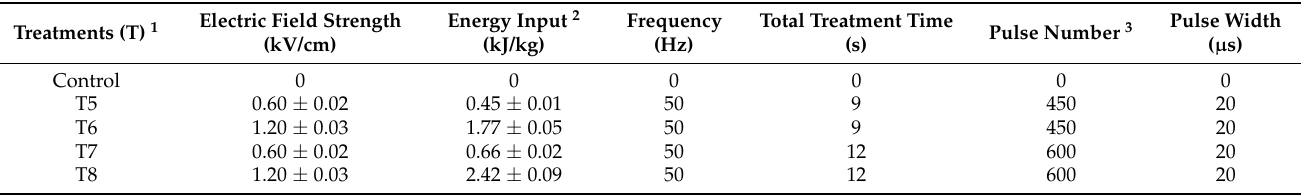
Table 2. Pulsed electric field treatment parameters applied in experiment 2. Electric field strength and total specific energy input values are expressed as means ± standard